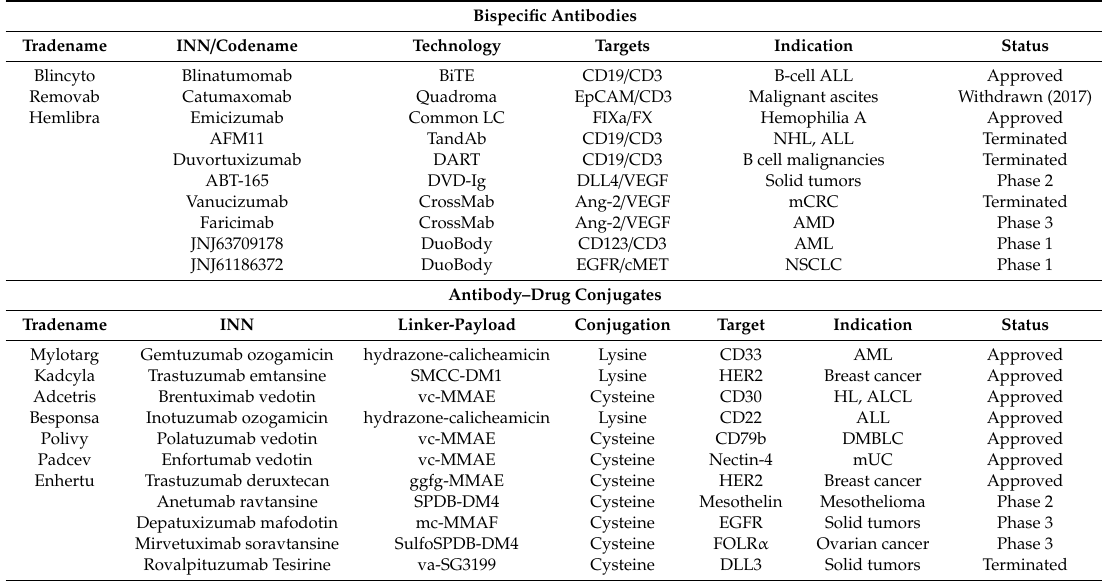
Table 1. Approved and clinical stage bispecific antibodies and antibody–drug conjugates discussed in this review